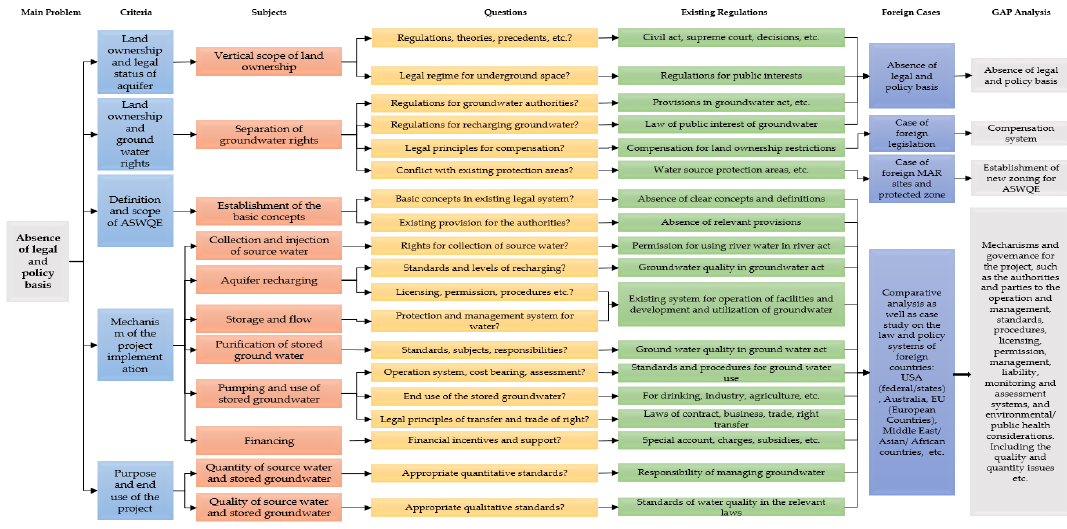
Figure 2. Issue tree analysis for the aquifer storage and water quality enhancement (ASWQE) projects in Korea. MAR: management of aquifer recharge.